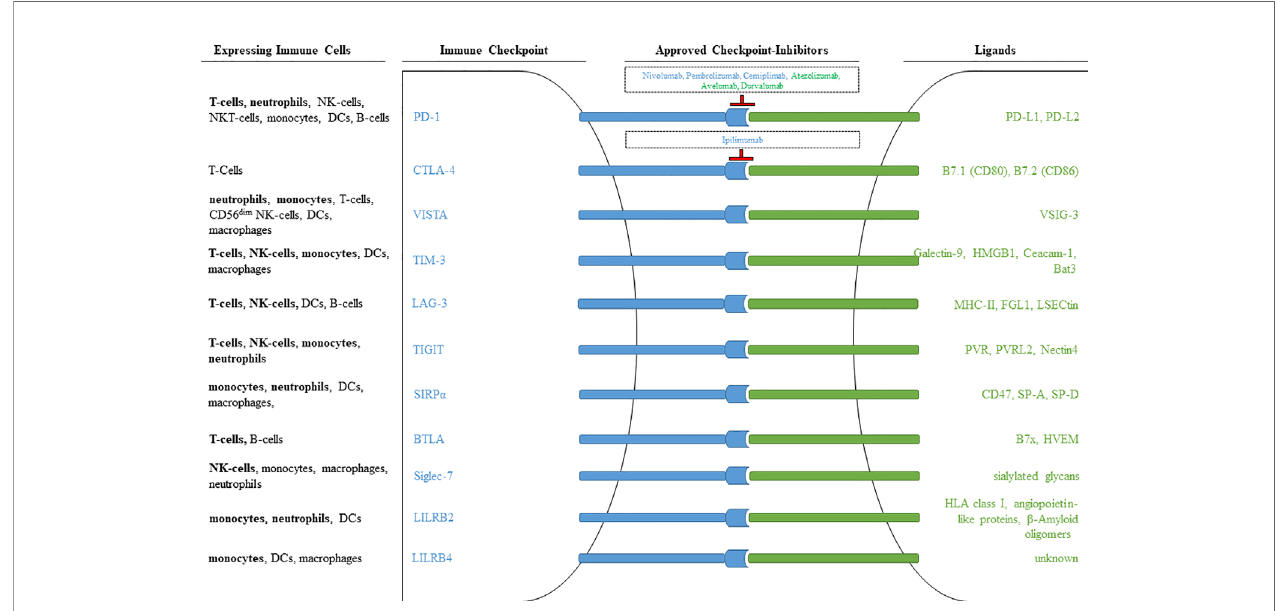
FIGURE 13 | Immune checkpoints observed on different immune cells. Inhibitory receptors expressed on different immune cells are illustrated as blue rods, and ligands for these receptors are illustrated as green rods. FDA approved monoclonal antibodies that block receptor-ligand interaction are shown within the outlined boxes. Checkpoint inhibitors targeting the receptor are marked in blue, checkpoint inhibitors targeting ligands are marked in green. Immune cell populations printed in bold signalize that the respective immune checkpoint was included in our own antibody-panel (provided in Table 1 ) and that we were able to detect